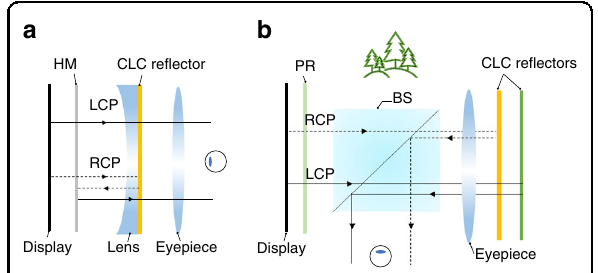
Fig. 13 Applications of CLC re fl ector in AR/VR. a Foveated VR display; b Multi-depth AR